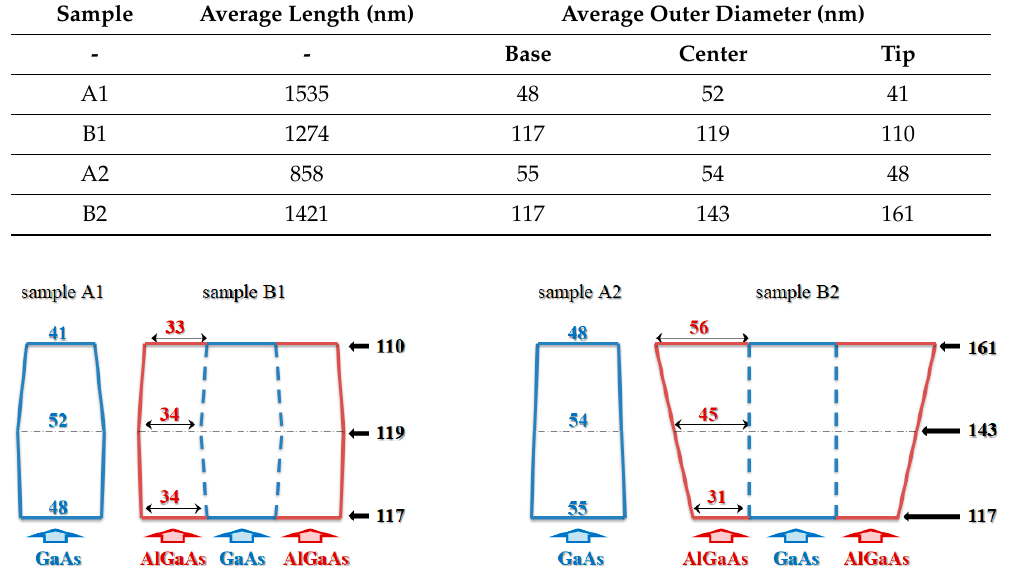
Figure 2. Schematic of the geometrical features of the four types of NW samples investigated in this work: not-tapered homogeneous GaAs NWs (samples A1 and A2), not-tapered core–shell GaAs–AlGaAs NWs (sample B1), and tapered core–shell GaAs–AlGaAs NWs (B2). Label numbers are expressed in nm and indicate: diameter of GaAs samples A1 and A2 (blue colored); thickness of AlGaAs shell in samples B1 and B2 (red colored); outer diameter of samples B1 and B2 (black colored). Variable-angle specular reflectance was measured over a spectral range from 400 to 1200